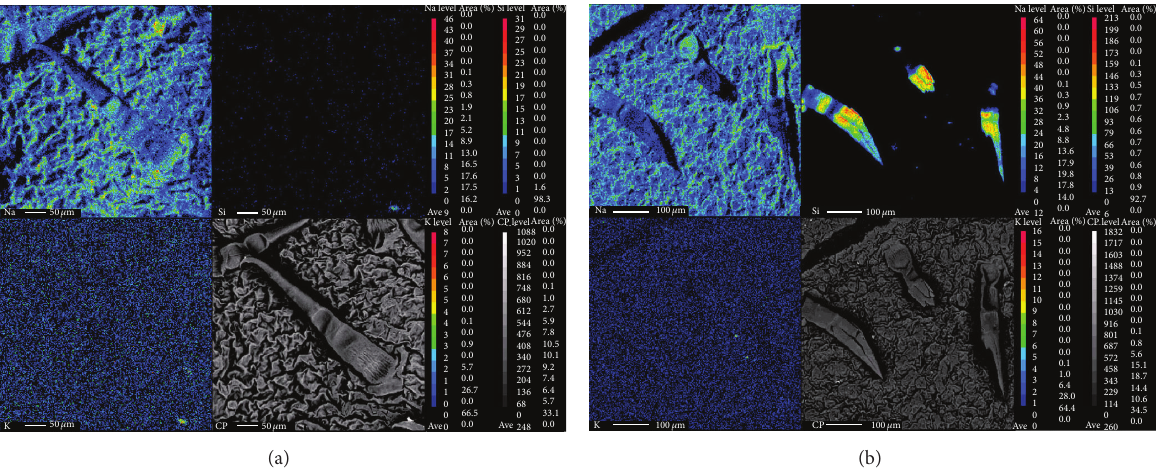
Figure 5: Wavelength dispersive X-ray analysis of Si-treated and nontreated leaves of A. multiflora . (a) MS medium and (b) MS +